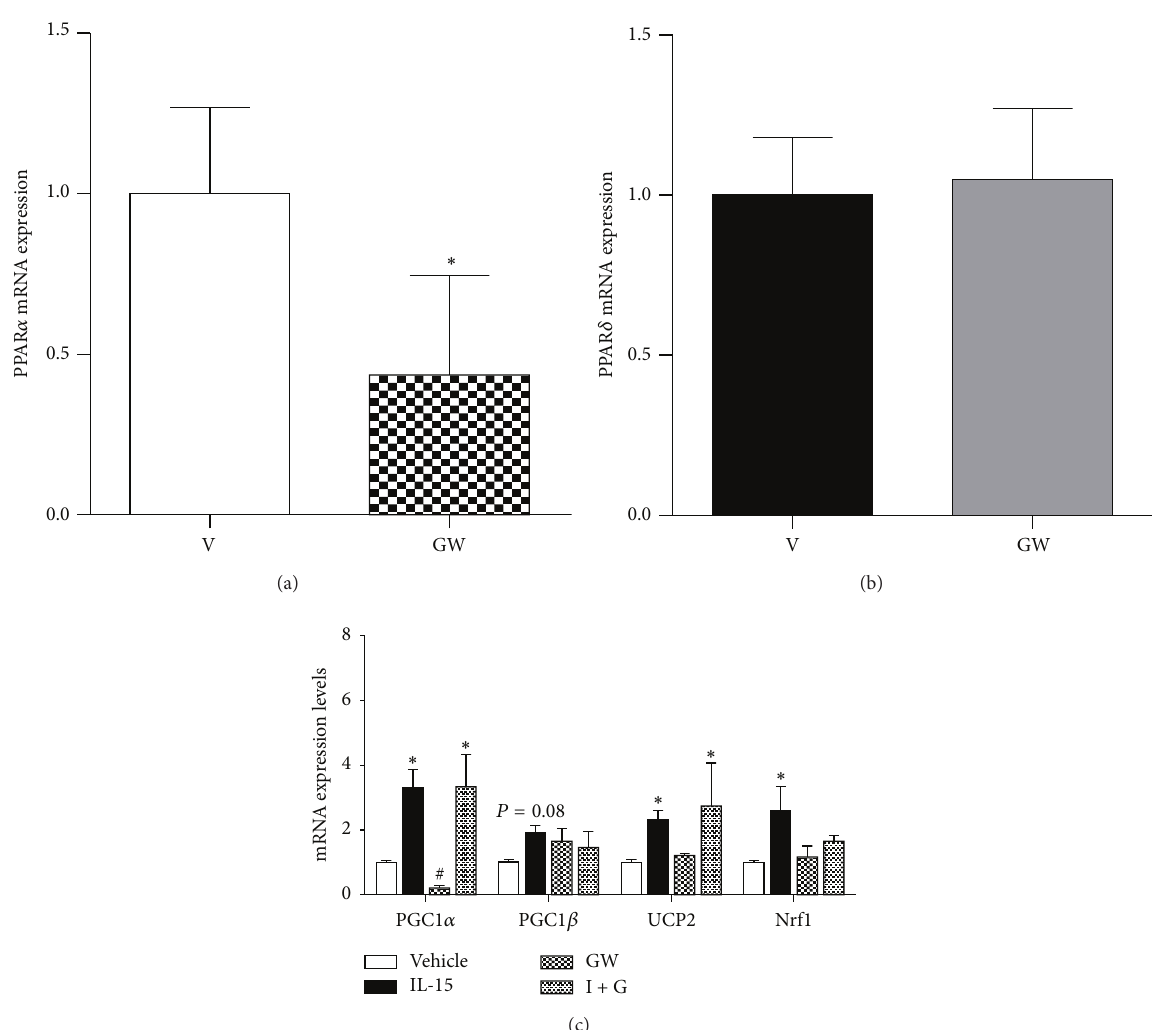
Figure 4: Effects of PPAR 𝛼 inhibition on IL-15 mediated alterations of mitochondrial associated factors. (a) mRNA expression of PPAR 𝛼 following inhibition with GW-6471 (GW); (b) mRNA expression of PPAR 𝛿 following exposure to GW; (c) mRNA expression of PGC1 𝛼 , PGC1 𝛽 , UCP2, and Nrf1 with IL-15 treatment in combination with GW. Throughout differentiation, cells were treated every other day, for 6 days, with either vehicle control (DMSO), IL-15 (100ng/mL), 10 𝜇 M of the PPAR 𝛼 inhibitor (GW-6471), or IL-15 + GW-6471 (I + G). GAPDH was used as an internal control for qPCR analysis. All values are displayed as means ± SEM, 𝑛 = 6–9 per group, ∗ different from vehicle and GW groups; # different from all groups; 𝑃 < 0.05